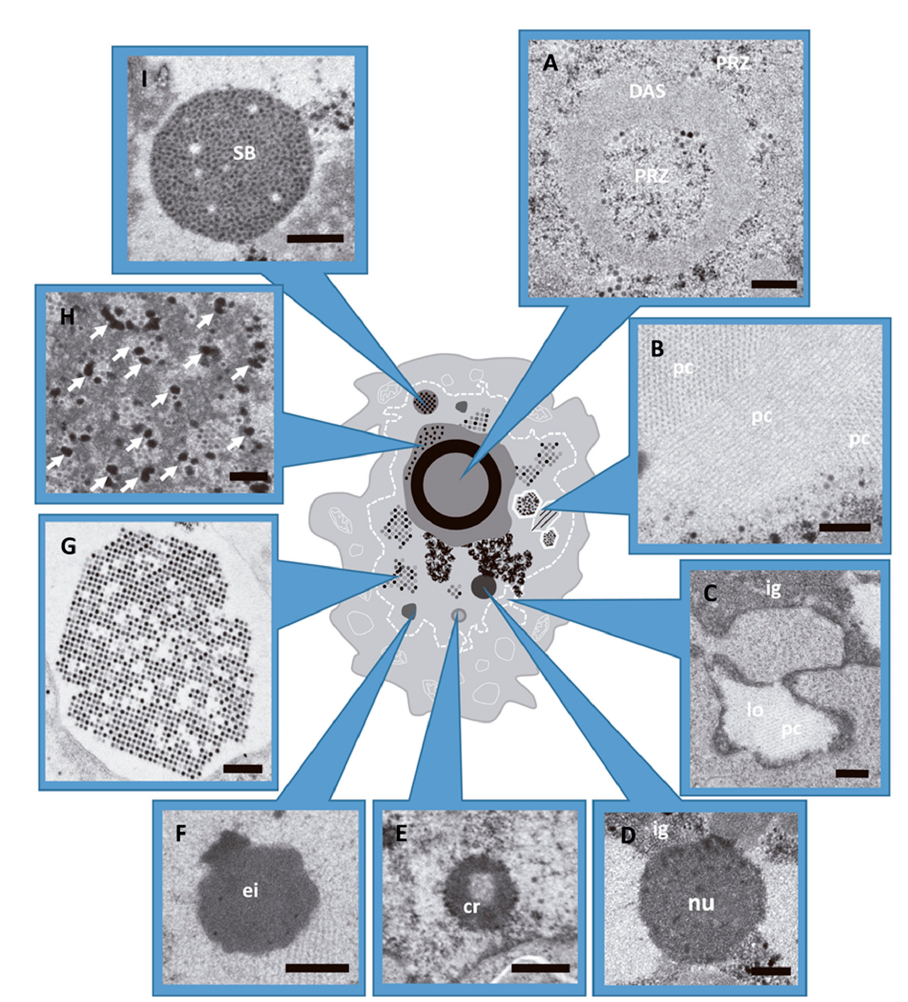
Figure 1. AdV induced alterations in the host cell nucleus during infection. HEK293 cells infected with AdV and embedded in Epon (see Methods). ( A ) Peripheral replicative zone (PRZ) and ssDNA accumulation site (DAS). Cell infected with Ad5GL at 48 hpi. ( B ) Viral protein crystal (pc), cross and longitudinal section. Ad5GL infection at 48 hpi. ( C ) Lobule (lo) and cluster of interchromatin granule (ig). Ad5/FC31 infection at 24 hpi. ( D ) Nucleolus (nu) from cell infected with Ad5GL at 48 hpi. ( E ) Compact ring (cr). Ad5/FC31 infected cell at 24 hpi ( F ) Electron-dense inclusion. Ad5/FC31 infection at 48hpi ( G ) Section of a paracrystalline array of virus particles (cell infected with Ad2 ts1 at 48 hpi). ( H ) Electron-dense granules (arrows) located within the PRZ. Ad5/FC31 infection at 48 hpi. ( I ) Speckled body found in Ad5/FC31 infection at 56 hpi. ( A – D , F , H ) Bar: 400 nm. ( E , G , I ) Bar: 500 nm. Images obtained by the authors during a survey of morphological changes in HEK293 cells infected with different Ad5/Ad2 variants. Panels D and I modified from